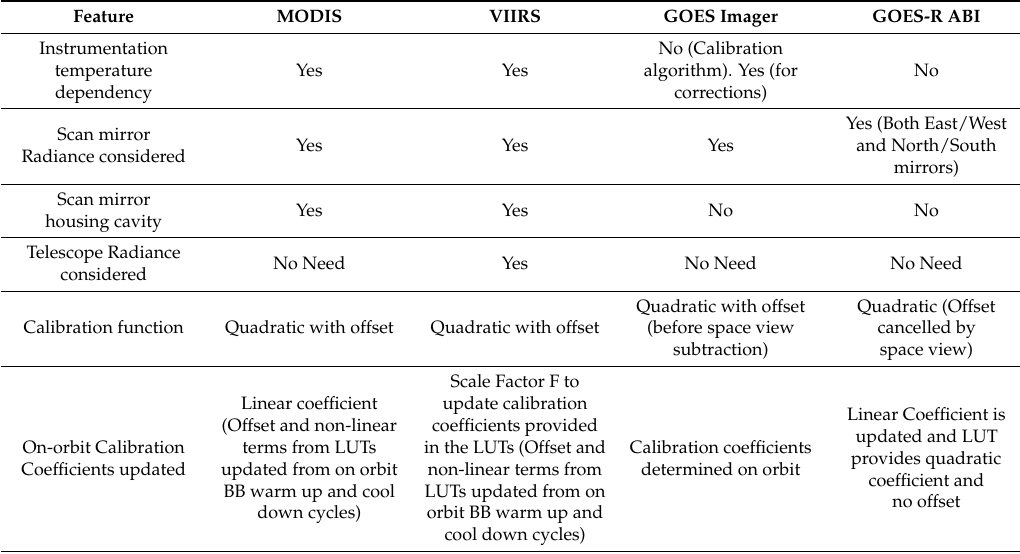
Table 5. Comparison of various features of Emissive band calibration of the four